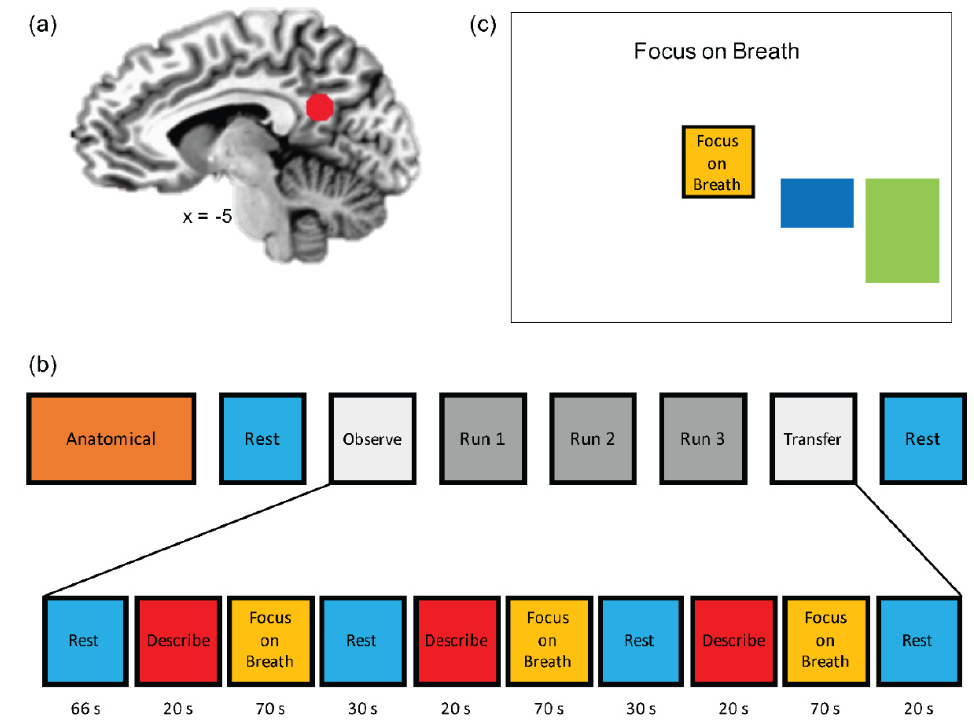
Figure 1. Real-time fMRI neurofeedback-augmented mindfulness training task [49]. ( a ) Posterior cingulate cortex (PCC, MNI coordinates: x = − 5, y = − 55, z = 23) was selected as the target (ROI,